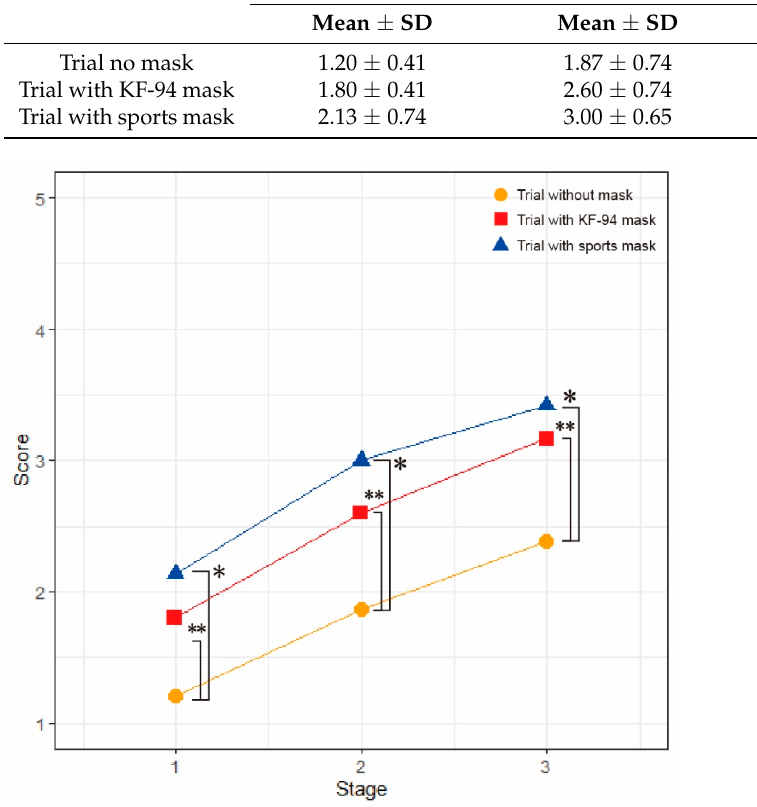
Figure 4. Comparison of subjective ratings of discomfort among KF-94 mask, sports mask, and no mask conditions. Data were analyzed using the paired t-test or Wilcoxon signed-rank test depending on the normality compared between conditions. * p < 0.05 when comparing trials between no mask and sports mask conditions, ** p < 0.05 when comparing trials between no mask and KF-94 mask conditions.